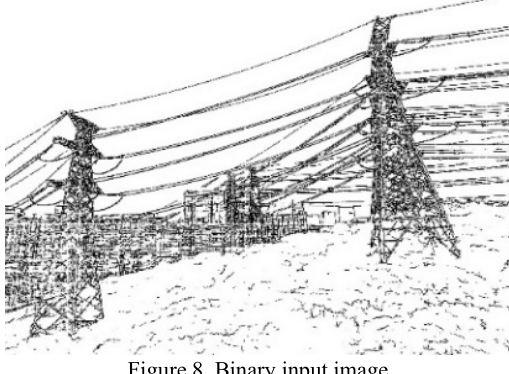
Figure 8. Binary input image